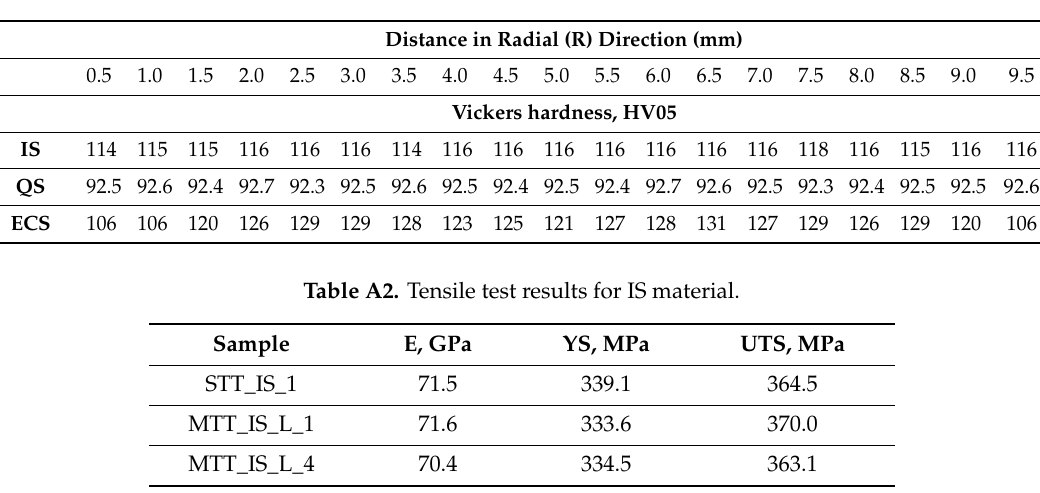
Table A1. Micro-hardness results for IS, QS and ECS states over their cross sections.